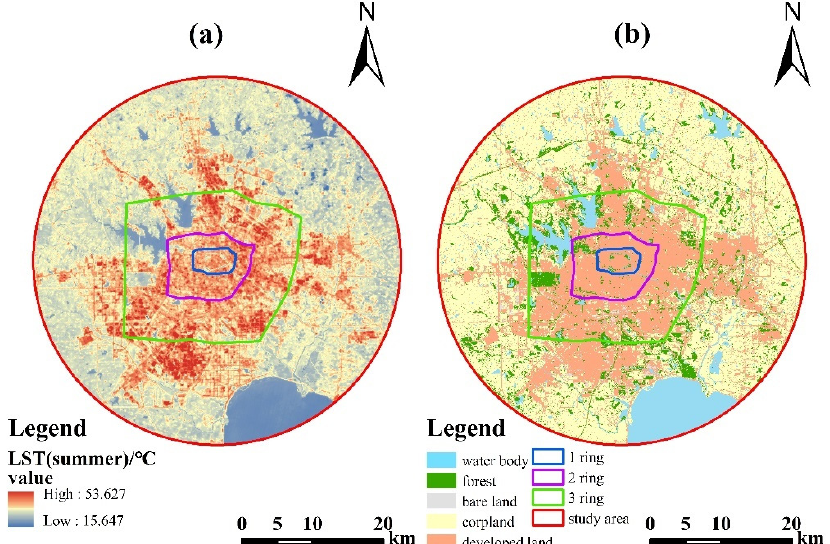
Figure 6. ( a ) LST distribution in summer of the study region; ( b ) land use types in the study re- gion. Table 3. Land surface temperature for each district.